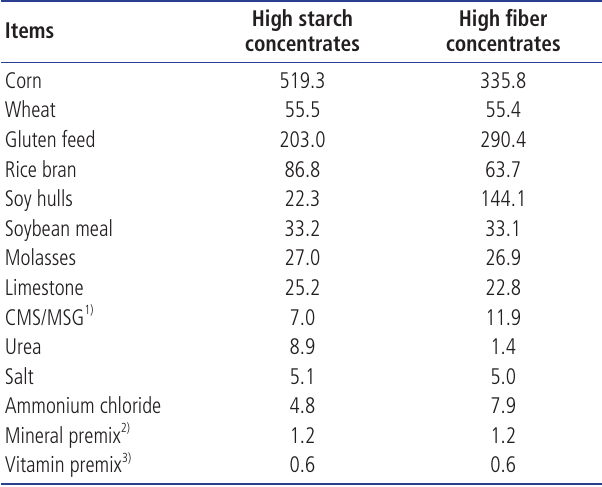
Table 1. Diet composition (g/kg) of experimental concentrate mixes Items